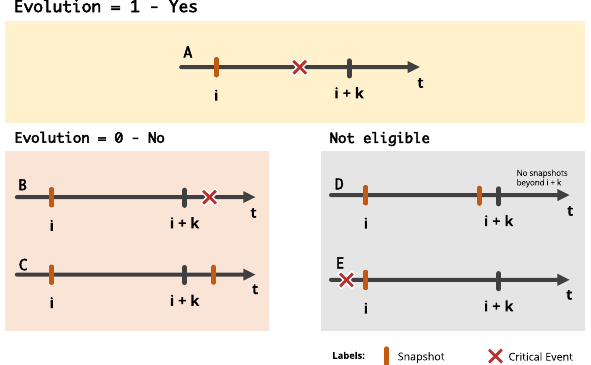
Figure 7. Definition of class Evolution (E) according to the patient’s evolution to a critical status in the interval of k days where i is the median date of the snapshot.